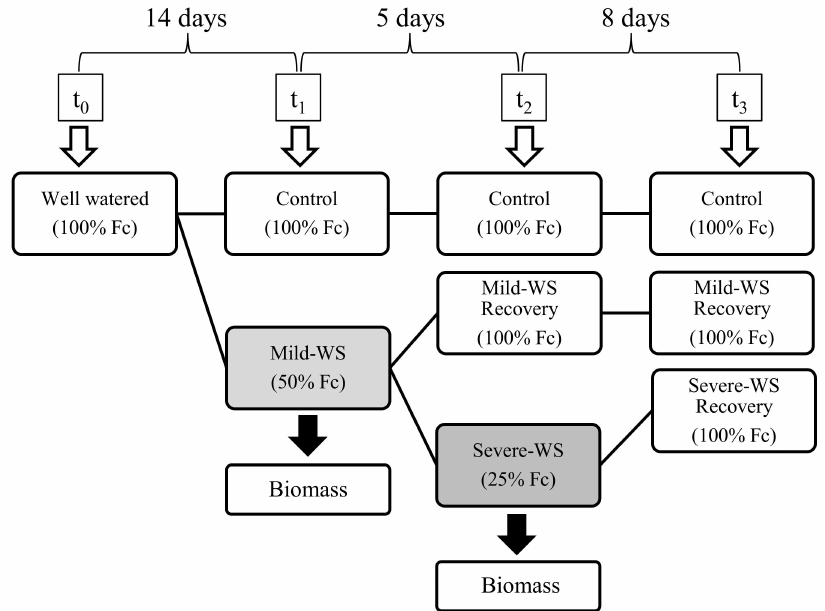
Figure 1. Schematic illustration of the experimental design. Control plants were maintained at field capacity (Fc) throughout the experiment, and water-stressed plants were subjected to substrate drying-up until they reached 50% of Fc (mild-WS; t 1 ) and 25% of Fc (severe-WS; t 2 ), respectively. Subsequently, plants were fully irrigated to assess the drought recovery response (t 2 and t 3